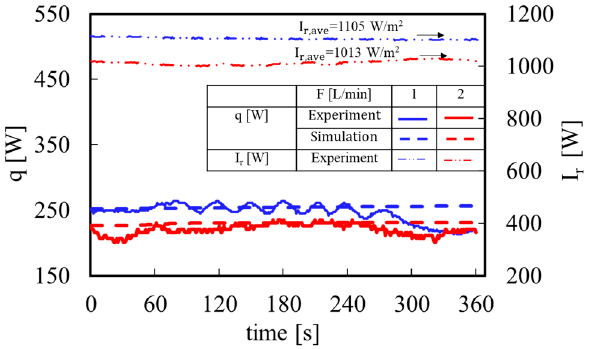
Figure 2. Recovered heat using pure silicone oil in simulations and experiments.